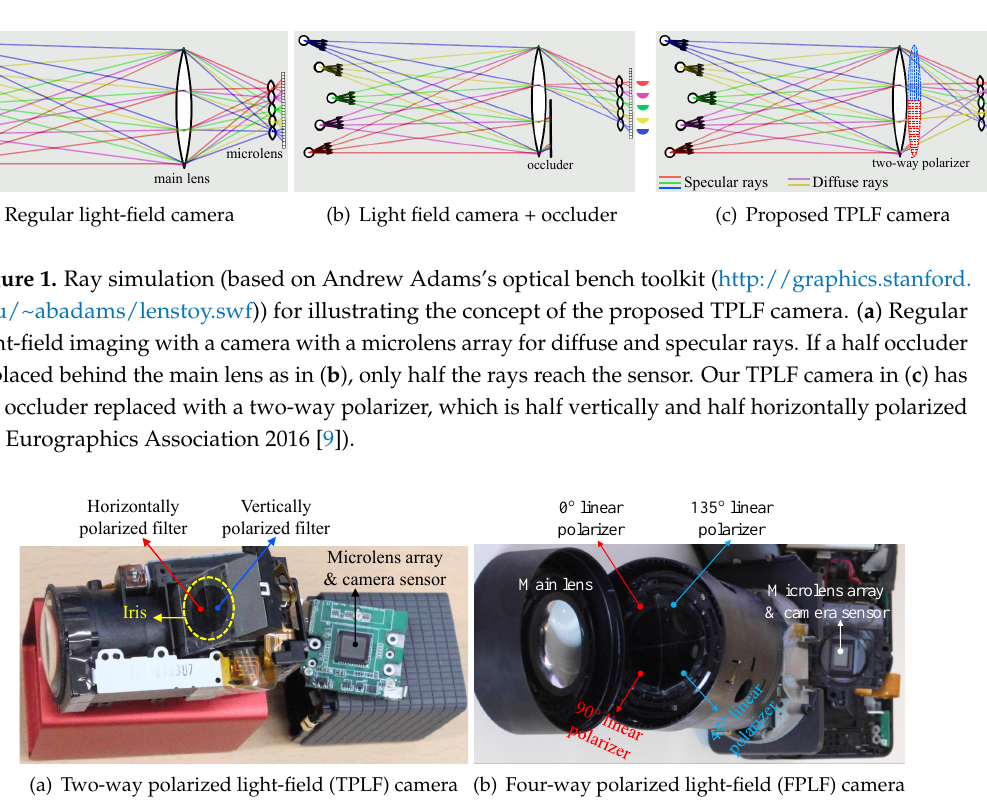
Figure 2. Our proposed polarized light-field cameras. ( a ) Components of the TPLF camera in disassembly employing a Lytro Red Hot camera (( c ) Eurographics Association 2016 [9]). ( b ) Lytro Illum camera employed for FPLF imaging with four linear polarizers at 0, 45, 90 and 135 ◦